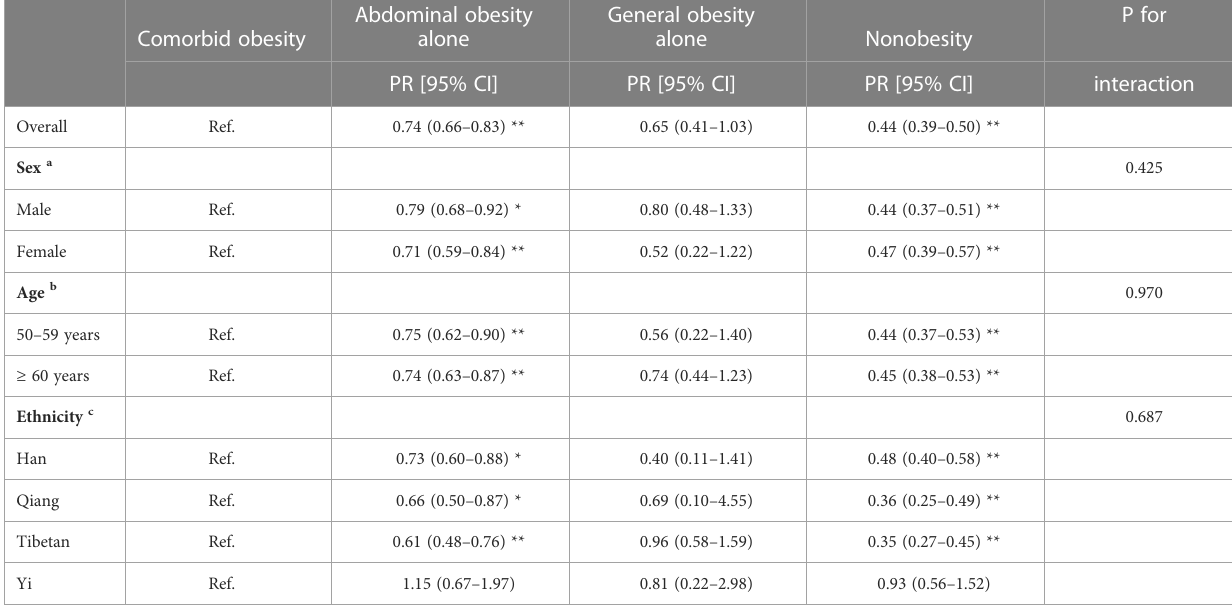
TABLE 6 Associations of obesity subgroups with low HDL-C levels in the adjusted